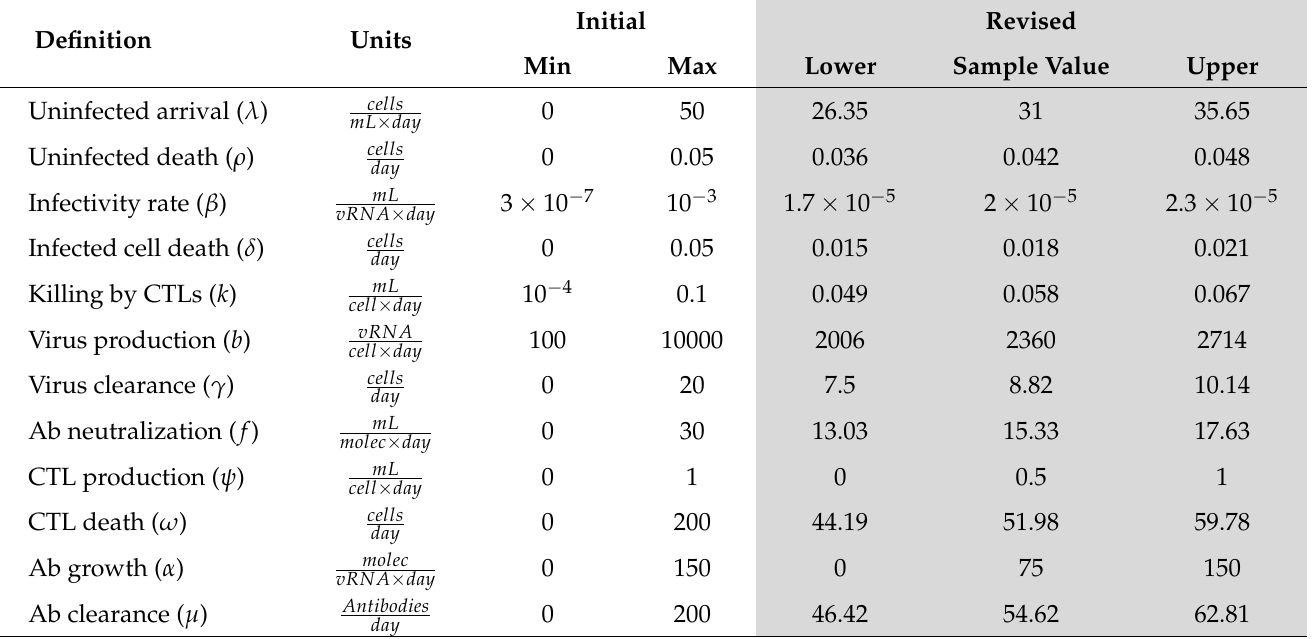
Table 1. Parameter definitions and ranges. The initial range expresses a naïve parameter set, which was then used to find sample values in the vicinity of the hyperbola asymptote using 10,000 Latin hypercube samples. The revised range was then determined by focusing on a 15% band above and below the sample